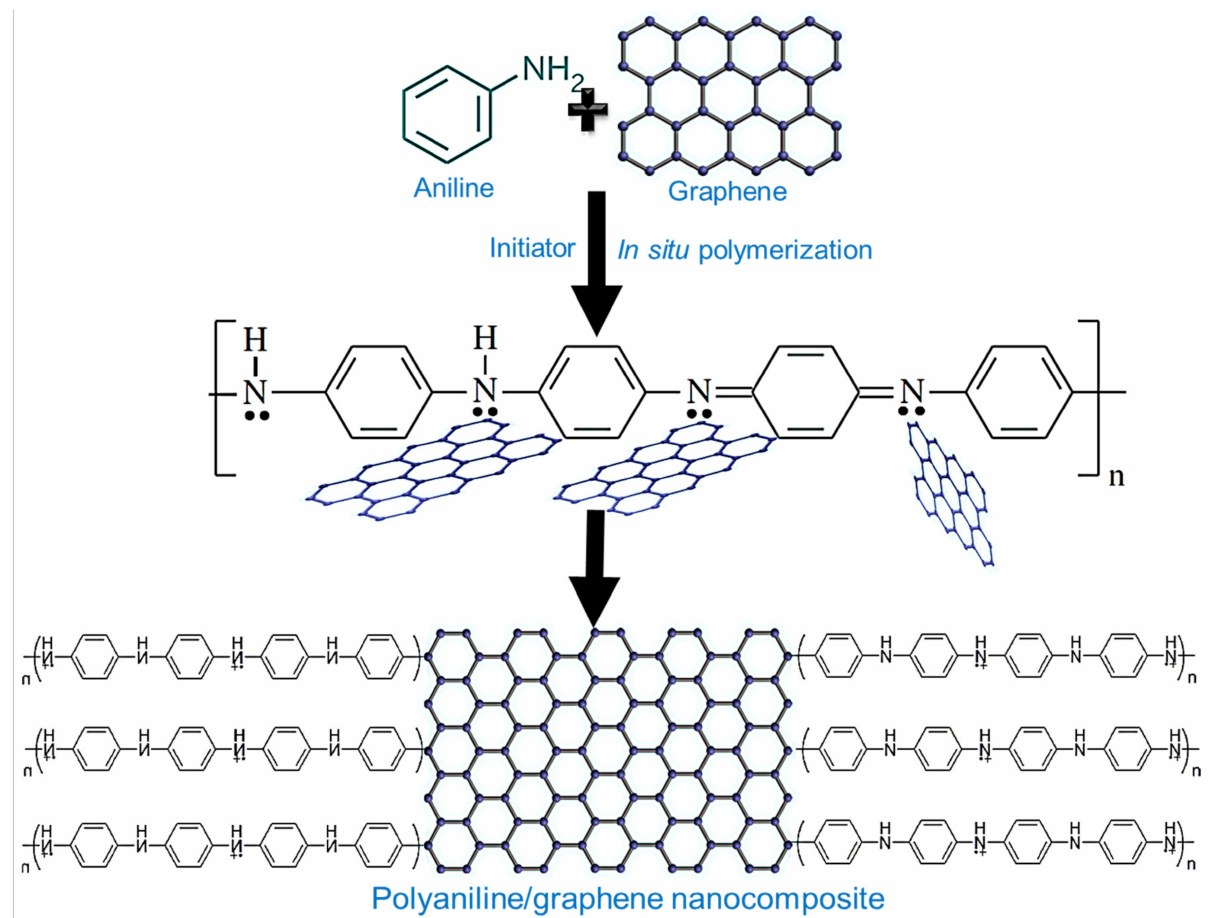
Figure 10. In situ polyaniline/graphene